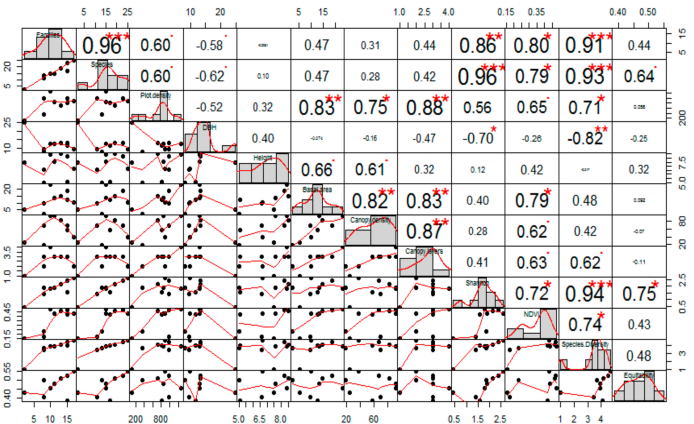
Figure 4. Correlation analysis of the pairwise interaction between NDVI and stand structural factors (number of families, number of species, plot density, DBH, height, basal area, canopy density, canopy layer, Shannon-Weiner , exponential Shannon index ( 1 D ), and Shannon equitability) of the study area, where * indicates p < 0.05, ** indicates p < 0.01 and *** indicates p <